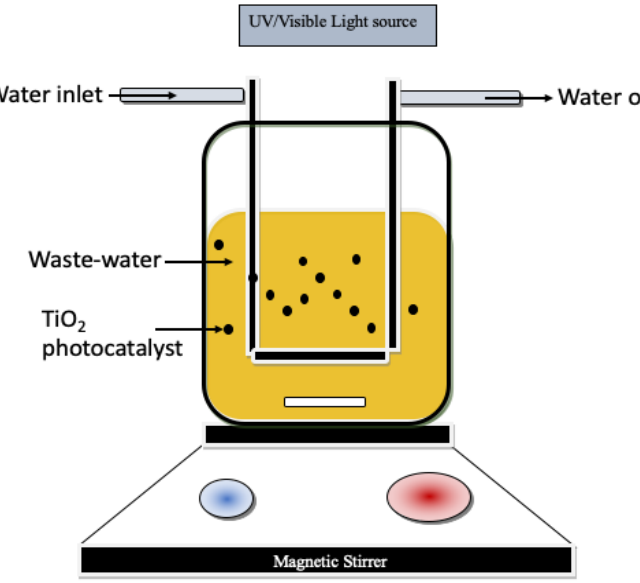
Figure 25. Experimental setup for dye degradation reaction.